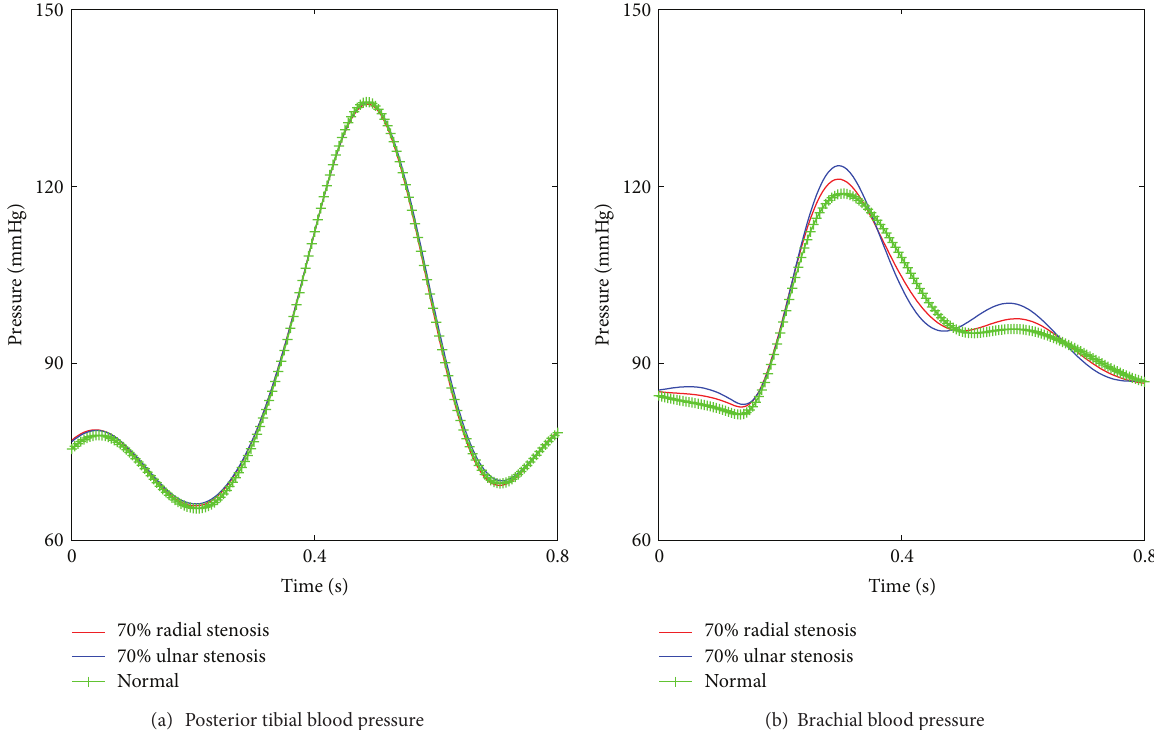
Figure 6: Comparison of the arterial blood pressure between the normal case and the cases with 70% radial stenosis and 70% ulnar stenosis respectively. (a) Posterior tibial blood pressure; (b) brachial blood pressure.